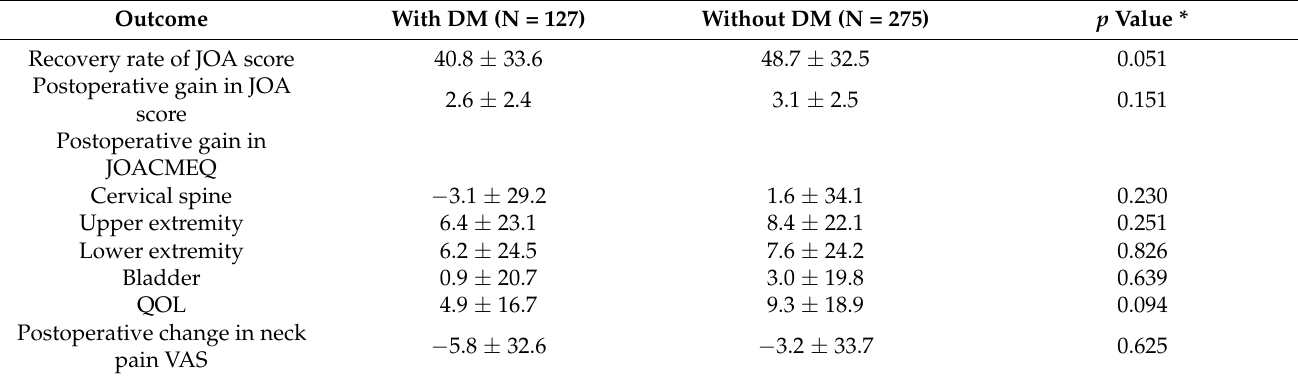
Table 4. Comparisons of postoperative functional gain between patients with and without diabetes mellitus.